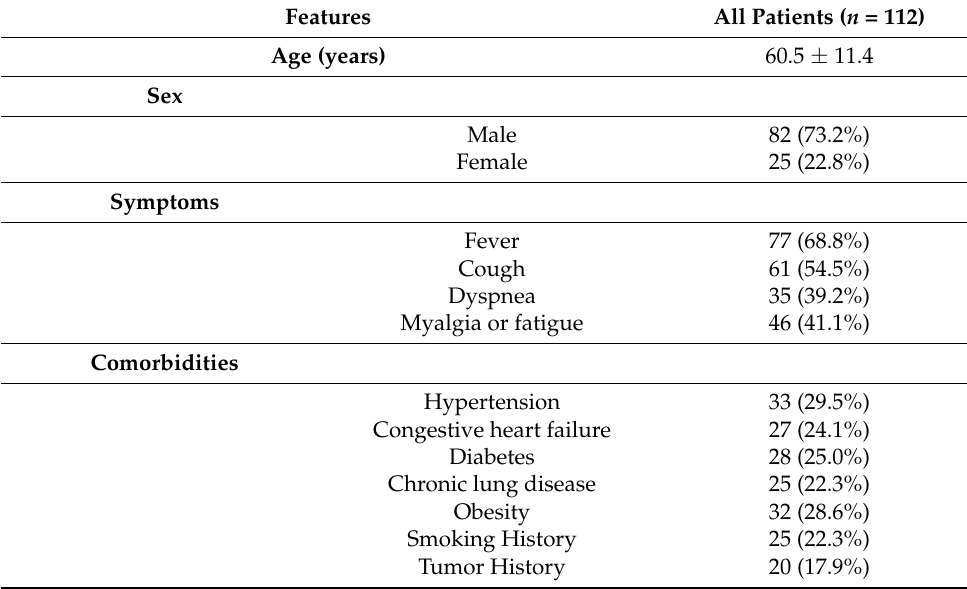
Table 1. Clinical features of the study